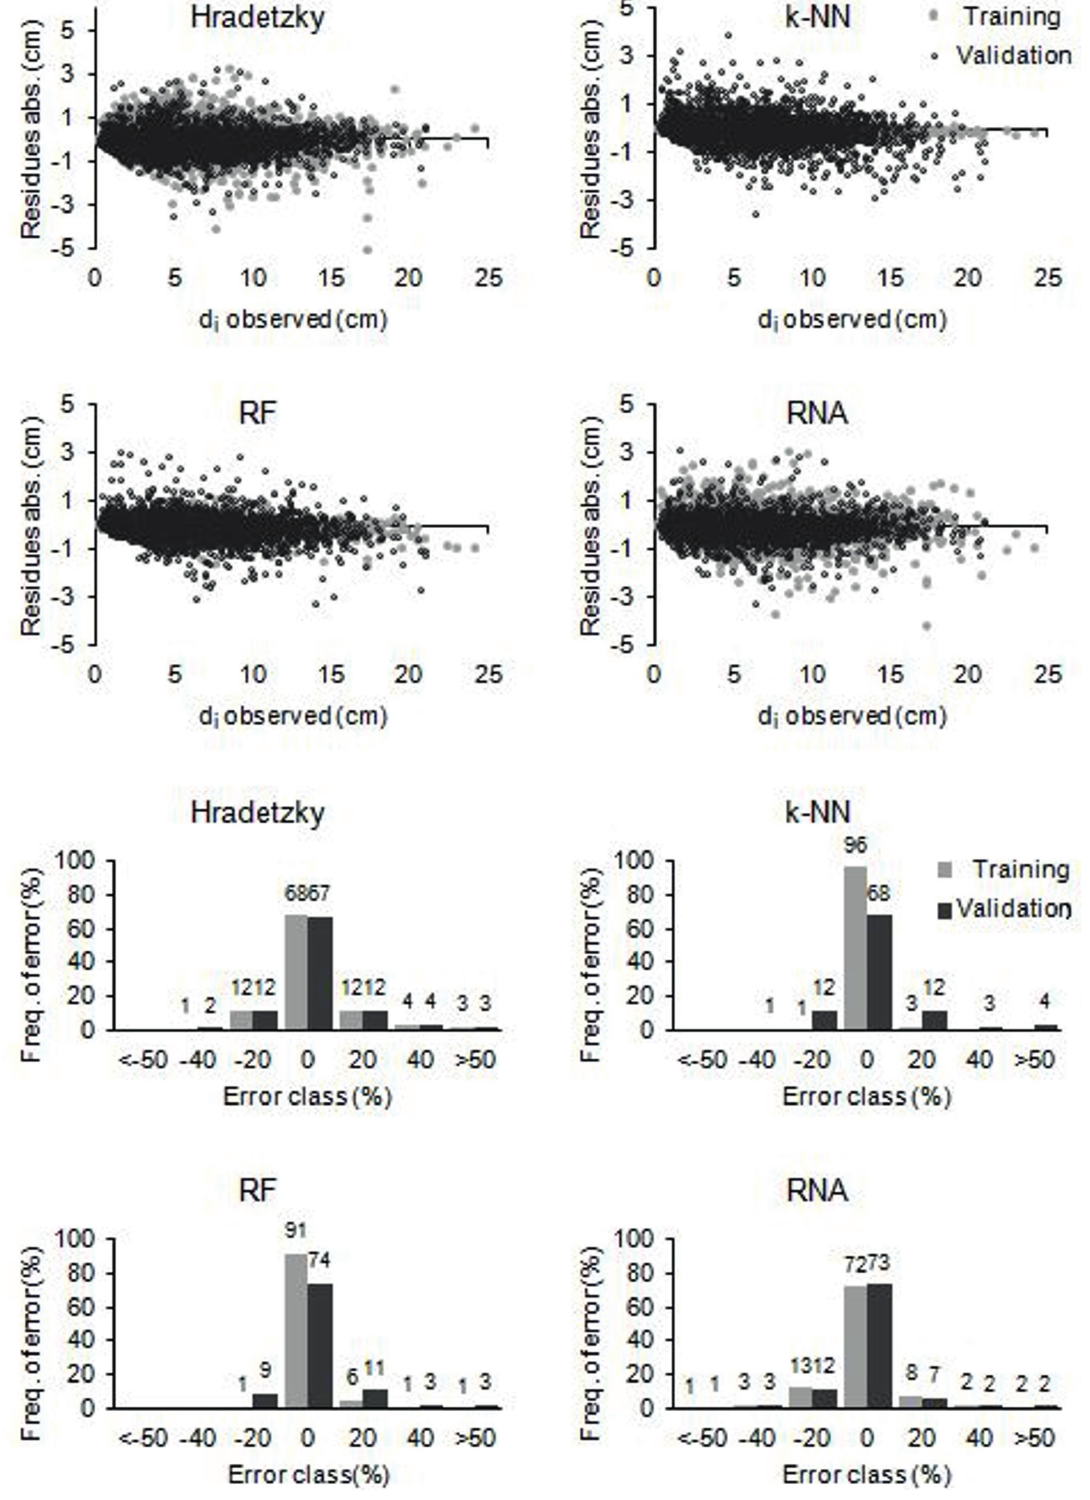
Figure 2 - Relative residues dispersion and frequency of percentual residues by error class for diameter estimation along the